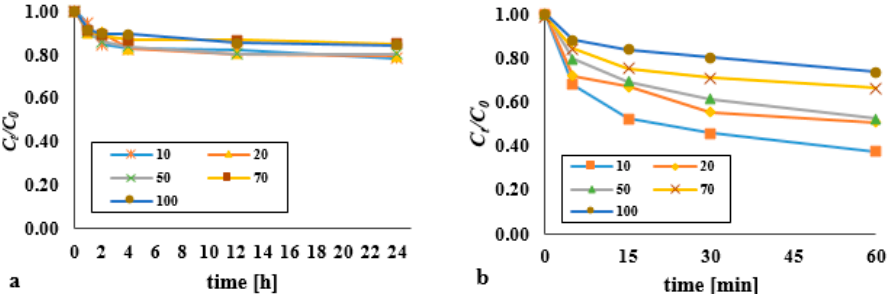
Figure 4. Influence of initial content on the decomposition of DEHP using ( a ) hydrogen peroxide (pH = 3, molar ratio DEHP:H 2 O 2 1:1); ( b ) hydrogen peroxide supported by an ultrasonic field (pH = 10, molar ratio DEHP:H 2 O 2 1:1, acoustic wave intensity of 3.97 W/cm 2